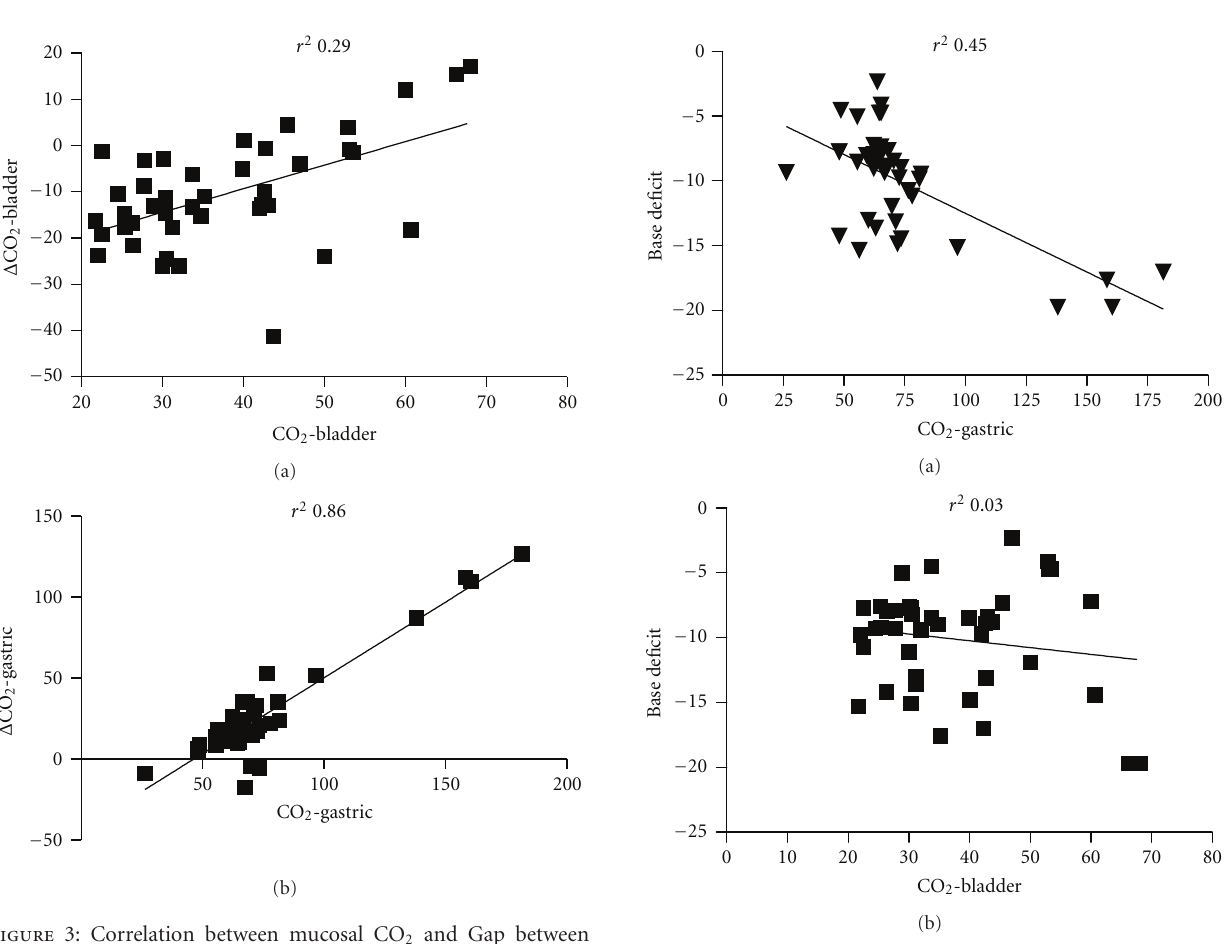
and base deficit in arterial